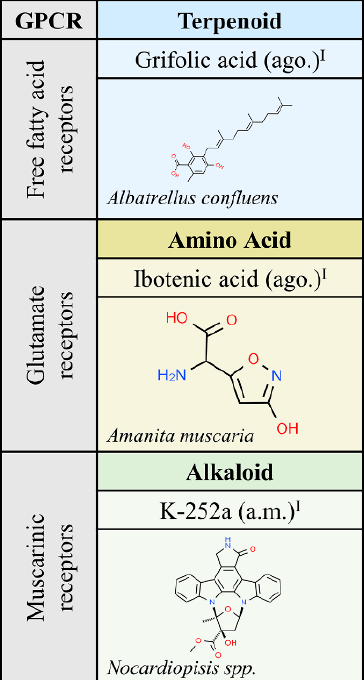
Figure 2. Natural ligands of GPCRs from Fungi. Each chemical class is highlighted with different colors. The chemical structures were found on ChemSpider website. Legend: ago.: agonist; ant.: antagonist; a.m: allosteric modulator. Superscript: (I) [1].